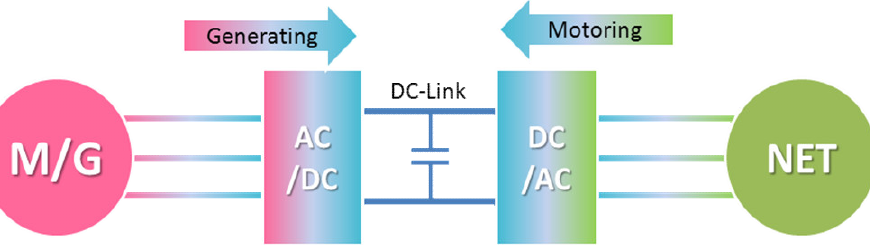
Figure 2. Electric/power generation system.